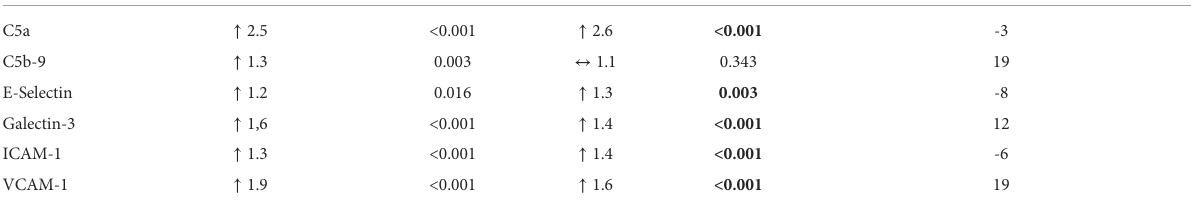
TABLE 3 Relative differences in inpatients vs. outpatients.